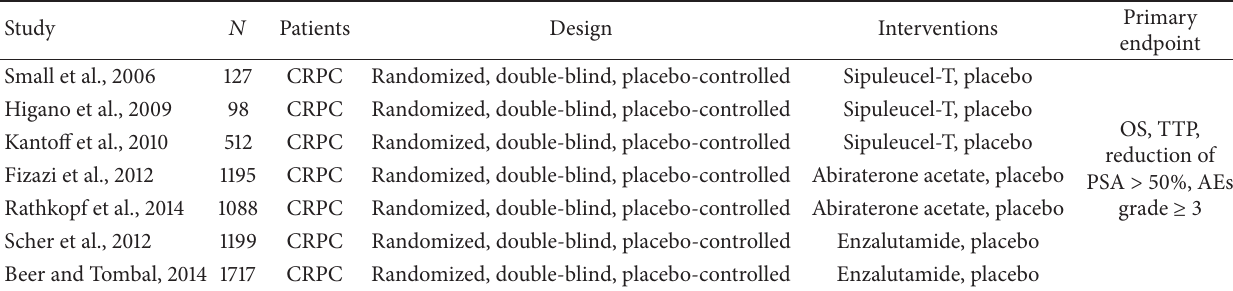
Table 2: Main characteristics of included studies.